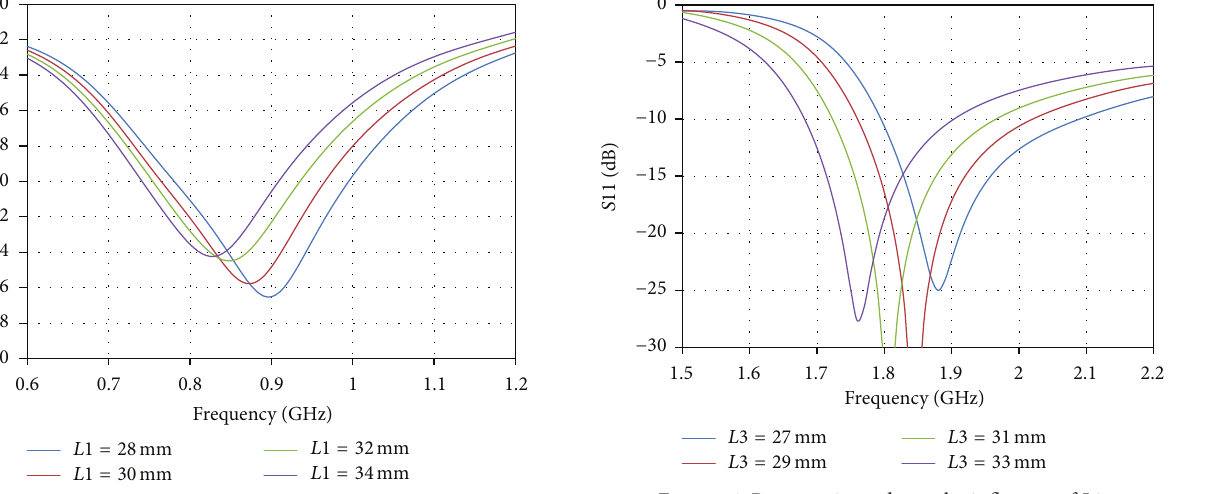
The radiation patterns obtained when the 4 different radiating elements are independently fed are presented in Figure 10. For the sake of clarity, each radiation pattern is